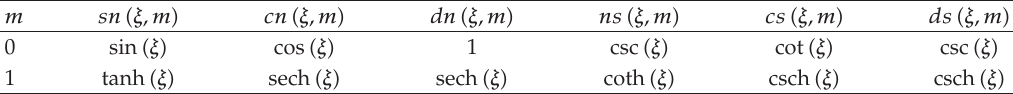
Table 1: The relation between the Jacobi elliptic functions and the trigonometrical functions, hyperbolic